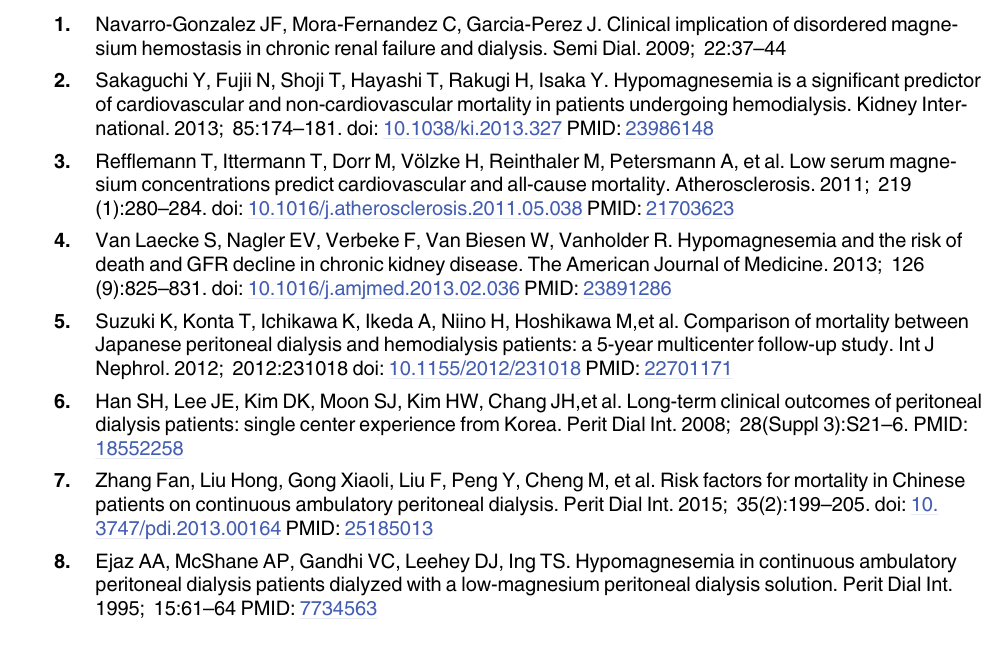
S1 Table. The data of the patients with